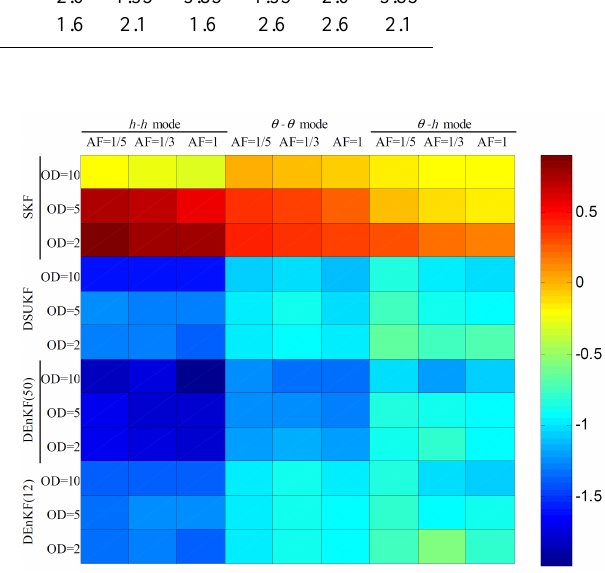
Figure 2. The colour scale indicates the logarithm of the ratio be- tween the RMSE of SKF, DSUKF, DEnKF(50) and DEnKF(12), and the corresponding RMSE of the open loop solution, for three retrieval modes ( h - h , θ - θ and θ - h) , three assimilation frequencies (AF = 1, 1/3 and 1/5d − 1 ) and three observation depths (OD = 2, 5 and 10cm). RMSE values have been averaged among the six initial guessed parameters sets